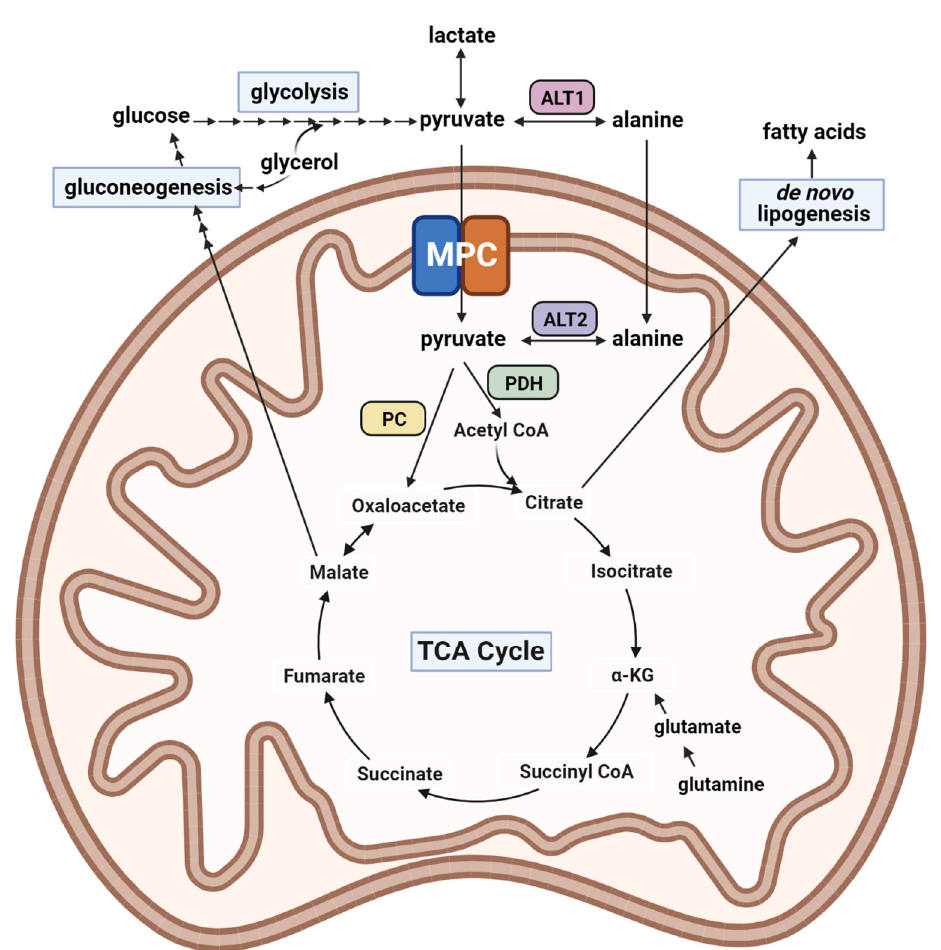
Figure 1. Pathways of intermediary metabolism. The schematic depicts pathways of intermediary metabolism relevant to mitochondrial pyruvate metabolism. Abbreviations: MPC, mitochondrial pyruvate carrier; ALT1, alanine transaminase 1; ALT2, alanine transaminase 2; PDH, pyruvate dehydrogenase; PC, pyruvate carboxylase; -KG, alpha-ketoglutarate. Created with BioRender.com. The inner mitochondrial membrane (IMM) is an impermeable barrier for most